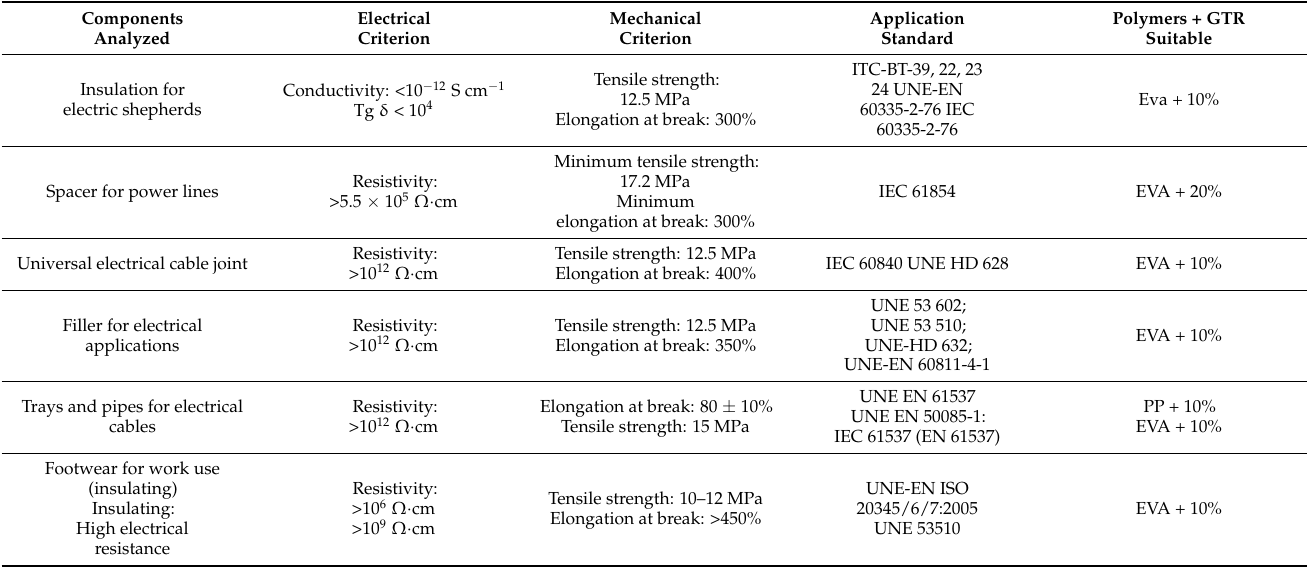
Table 5. Applications obtained for blend materials produced in [104] and the associated criteria and conformance standards. Adapted with permission from ref.